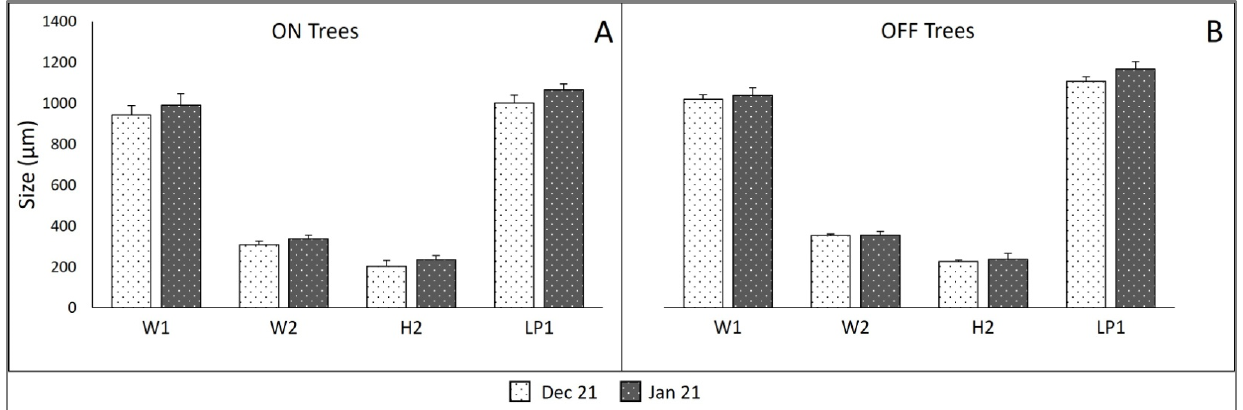
Figure 2. Bud internal dimensions for bearing (ON; ( A )) and nonbearing (OFF; ( B )) trees on sample dates 21 December and 21 January. W1 = width of bud base; W2 = width of the bud axis between the primordium axils of the first node; H2 = height between nodes 1 and 3; LP1 = length of the two leaf primordia of the first node. Each column represents the mean of 80 buds (OFF) or 60 buds (ON), based on 20 buds from 10 nodes per tree. Vertical bars = standard error.